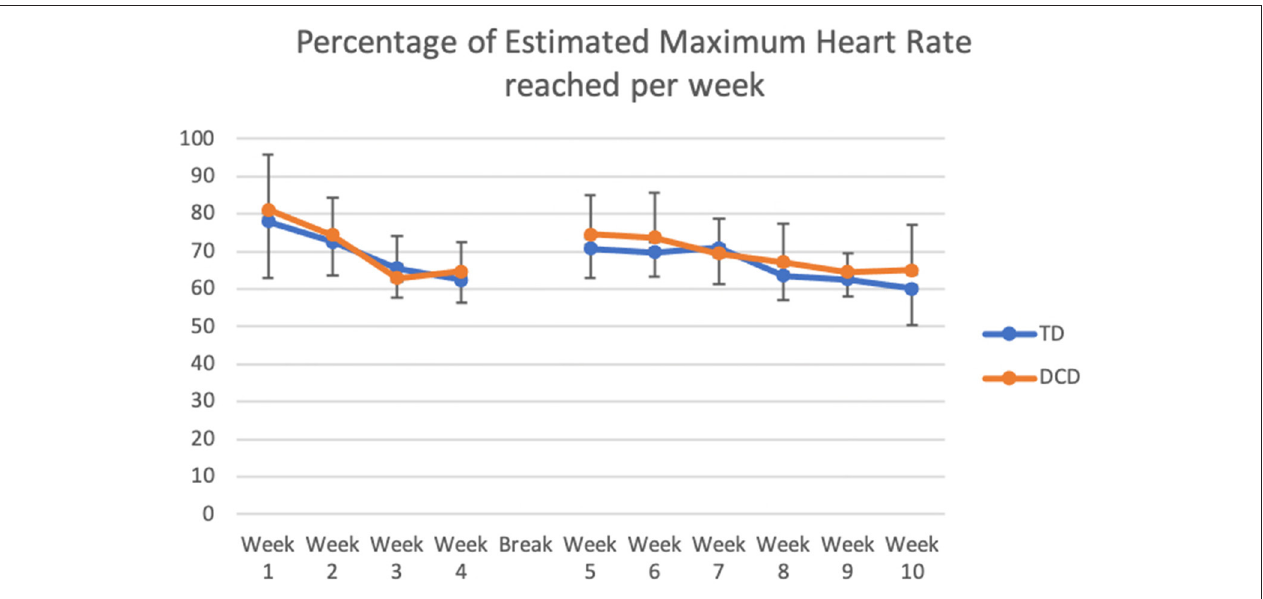
FIGURE 3 | Comparison of the percentage of Estimated Maximum Heart Rate that TD children and children with DCD reached during the 10 weeks of